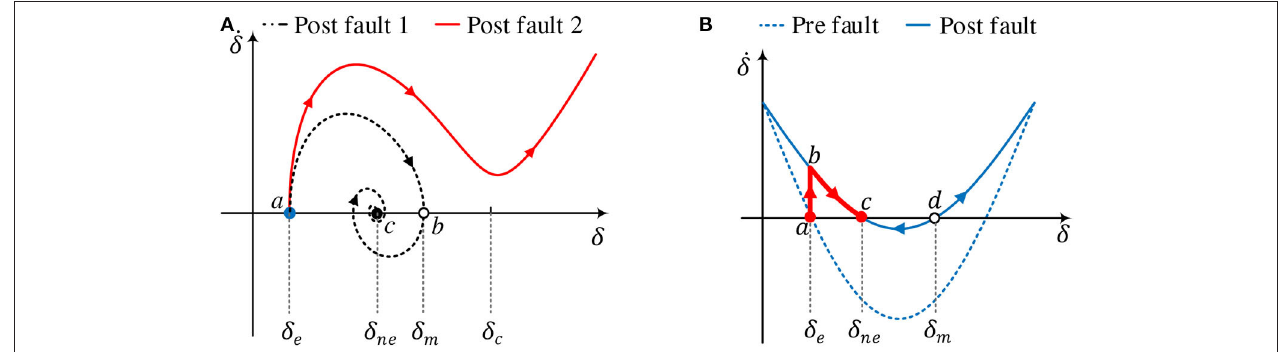
FIGURE 10 | Transient stability analysis using phase portraits: (A) droop control, (B)